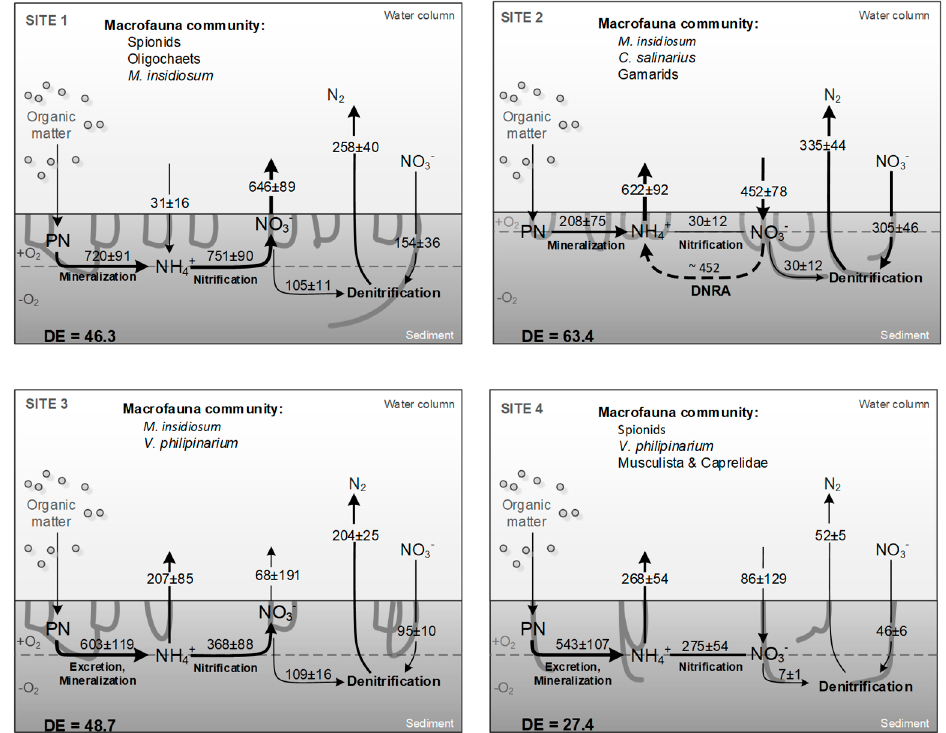
Figure 7. Flow scheme for benthic nitrogen (N) pathways for each site, which were calculated from combinations of measured fluxes and process rates. The mineralization of organic N was estimated as the sum of net NH 4+ and NO 3 − efflux and nitrification coupled to denitrification (Dn); nitrification rates were estimated as the sum of the net NO 3- efflux and Dn; net NO 3 − efflux is the sum of measured NO 3 − efflux and denitrification based on bottom water NO 3 − . The mean rates (average ± st. error) are expressed on an hourly basis per unit of sediment surface (µmol m − 2 d − 1 ). Dissimilative NO 3 − reduction to NH 4+ (DNRA) was not measured but is represented as a dotted line, a likely occurring path at site 2. Denitrification efficiency (DE) is the ratio between dinitrogen (N 2 ) flux and the sum of N 2 and dissolved inorganic N (NH 4+ +NO x − ) effluxes.